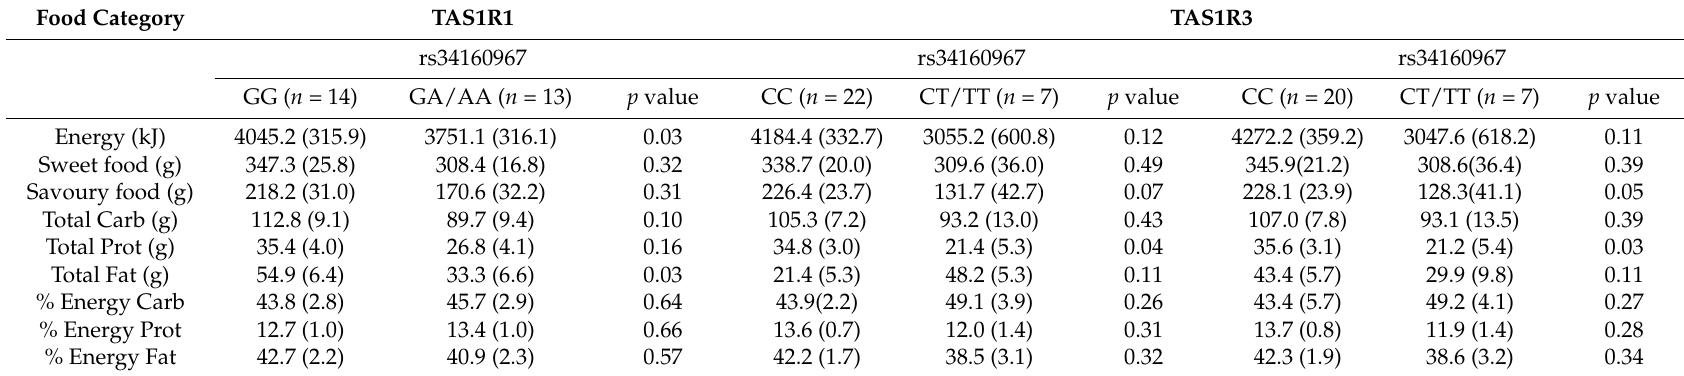
Data are shown as Mean (SEM); numbers in the bracket after different polymorphism indicate the number of participants; % Energy Carb, carbohydrate as percentage of energy; % Energy Prot, protein as percentage of energy; % Energy Fat, fat as percentage of energy; Carb: carbohydrate; Prot: protein; t; p value indicates the main effect of genetic variation (different SNP polymorphisms) using repeated